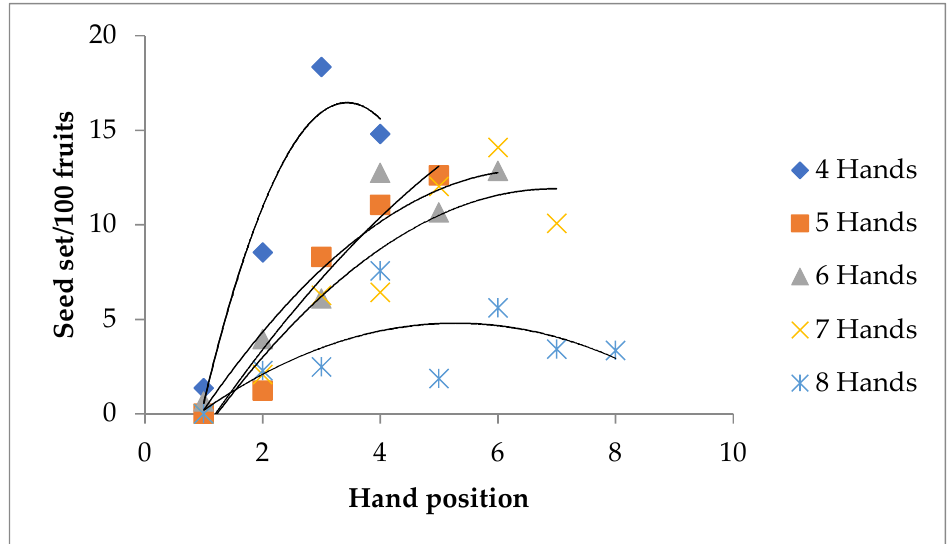
Figure 2. Seed set per 100 fruit per hand in different sized bunches of “Enzirabahima”.